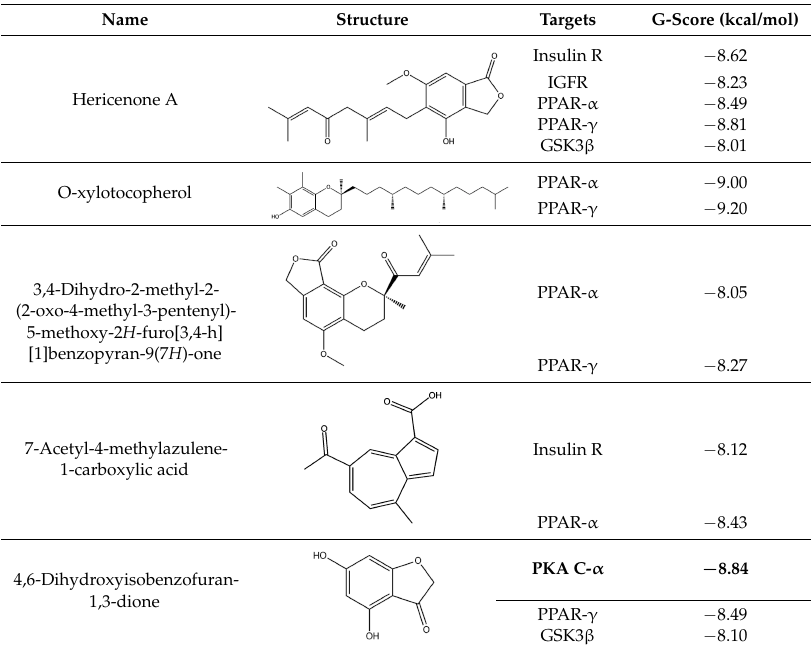
Figure 8. Molecular interactions of Pterulone and its four targets involved in the neurodegenerative diseases: ( A ) Protein target, COX-2 (PDB: 5IKR). Protein is shown as a turquoise cartoon while ligand is shown as green carbon sticks; ( B ) Protein target: MAO-B (PDB: 2V5Z). Protein is shown as a dark green cartoon while ligand is shown as yellow carbon sticks; ( C ) Protein target, AChE (PDB: 4EY7). Protein is shown as a red cartoon while ligand is shown as green carbon sticks; ( D ) Protein target, GSK3 β (PDB: 4ACC). Protein is shown as a light green cartoon while ligand is shown as orange carbon sticks. H-bonds and π - π interactions are shown as dashed black and cyan lines, respectively. Aminoacidic residues involved in the interactions are shown as gray sticks. Table 4. Fungal components with best theoretical affinities (G-score) against multiple targets involved in the metabolic diseases.